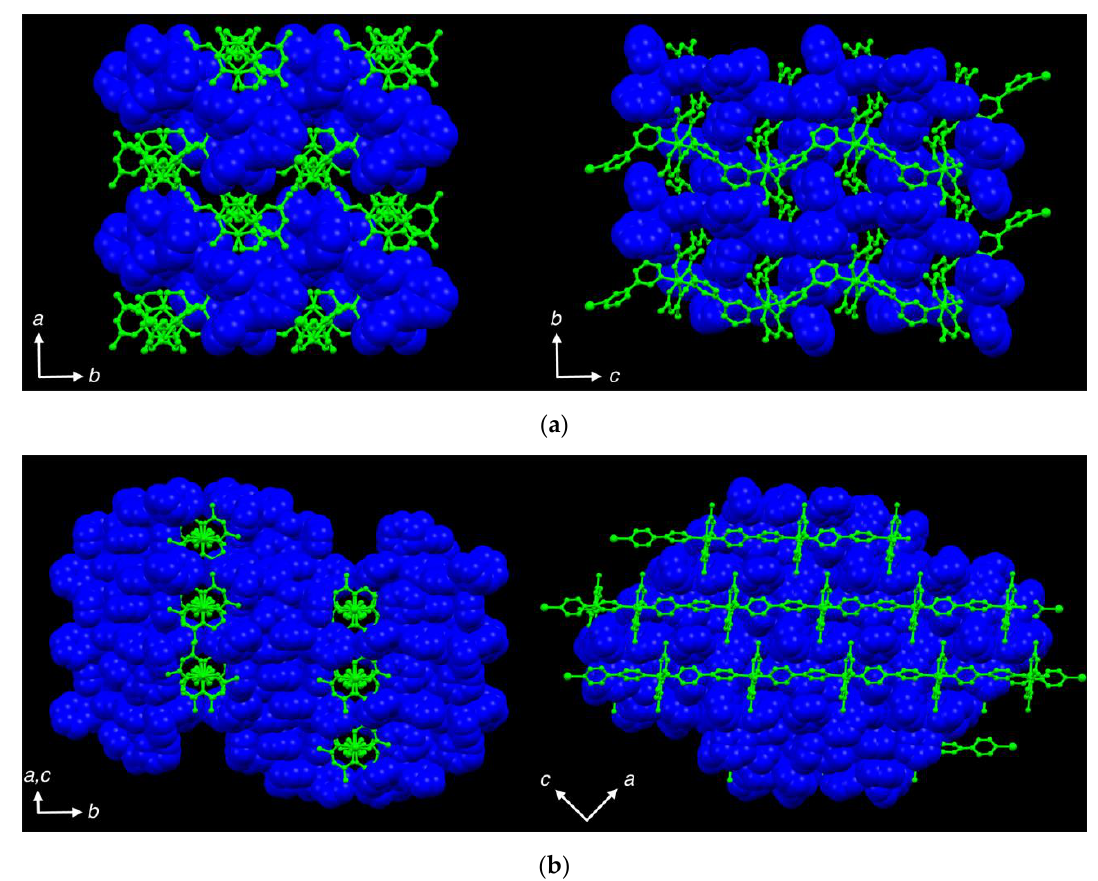
Figure 2. Crystal packing diagrams of ( a ) 1 and ( b ) 2 at 100 K, showing top (left) and side (right) arrangements of the cationic 1D chains as a green colored ball and stick model and other molecules as a blue colored space-filling model. H atoms are omitted for clarity.